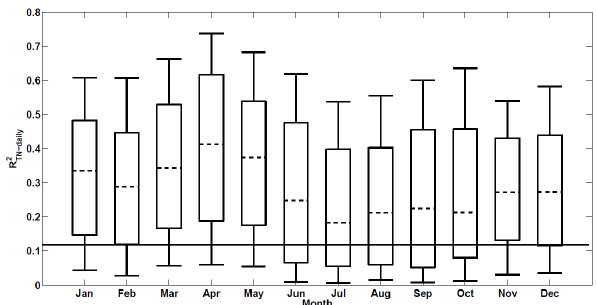
Figure 8. Box plot showing rank correlations between observed Figure 8: Box plot showing rank correlations between observed daily streamflow and forecasted 73 daily streamflow and forecasted streamflow aggregated over each streamflow aggregated over each month from 1979 to 2009 period. Each plot includes 558 74 month from 1979 to 2009. Each plot includes 558 correlations (18 correlations (18 stations × 31years). The solid line represents the statistically significant (95%) 75 stations × 31 years). The solid line represents the statistically sig- nificant (95%) R 2 corresponding to the null hypothesis that R 2 R 2 corresponding to the null hypothesis that R 2 being equal to zero. 76 equals